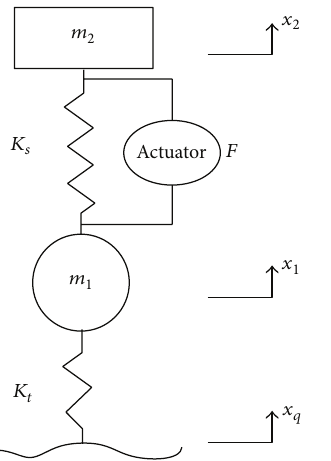
Figure 1: The quarter-vehicle body model of 2